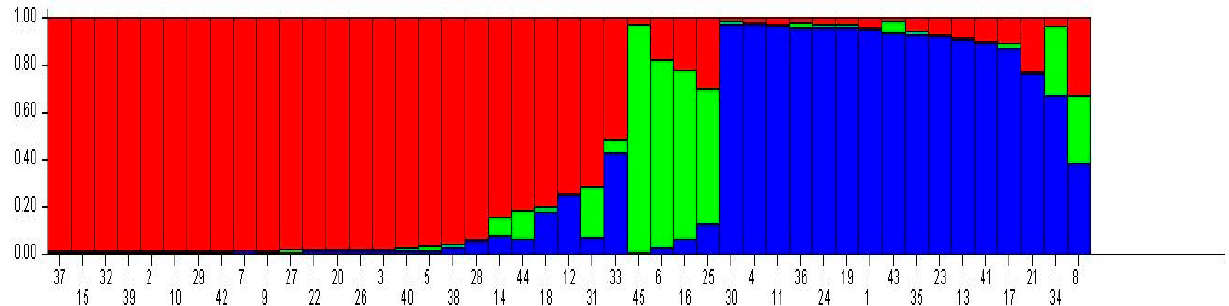
Figure 4. Bayesian inference clustering of 44 Coffea canephora and 1 Coffea arabica genotype. Genotypes are represented in the horizontal line and each genetic group is represented by a color. UENF, Campos dos Goytacazes, RJ, 2021.